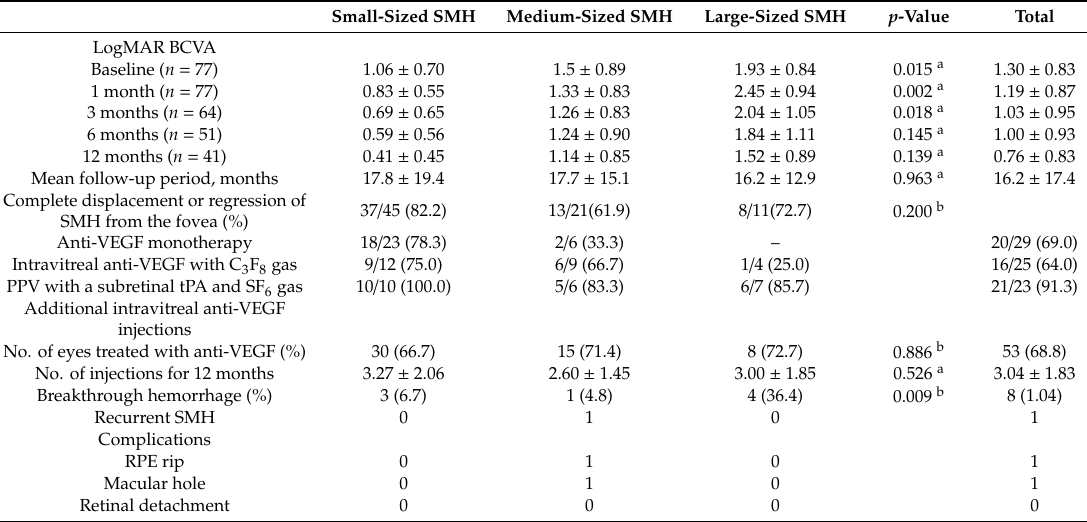
Table 2. Functional and anatomical